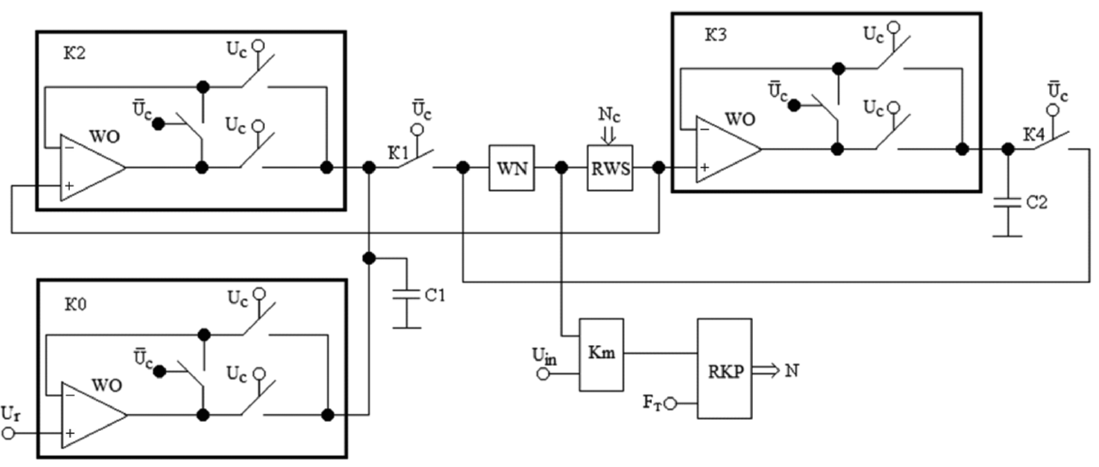
Figure 1. Simplified functional diagram of the LADC with successive approximation on switchable PK capacitors with a variable logarithm PK capacitors with a variable logarithm base.